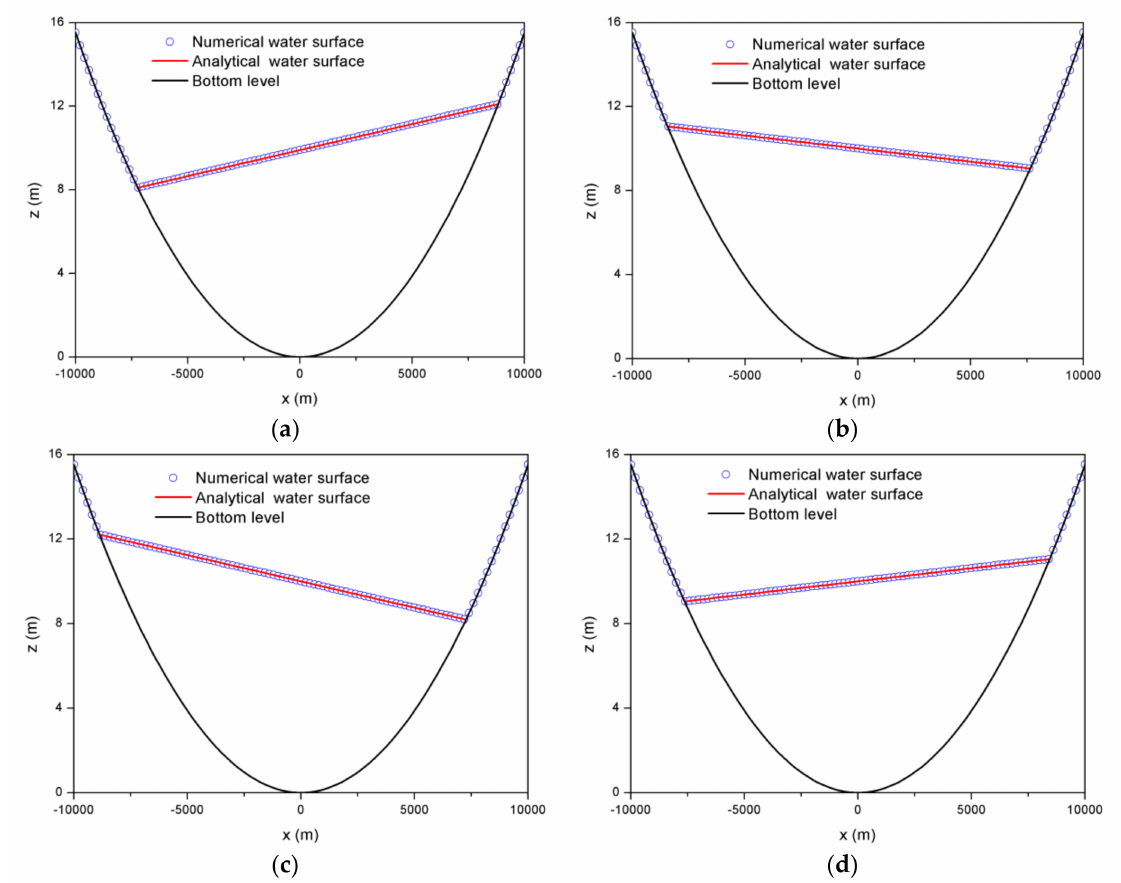
Figure 11. Comparison between simulated and analytical water surface for the mesh of ∆ L = 55.18 m.